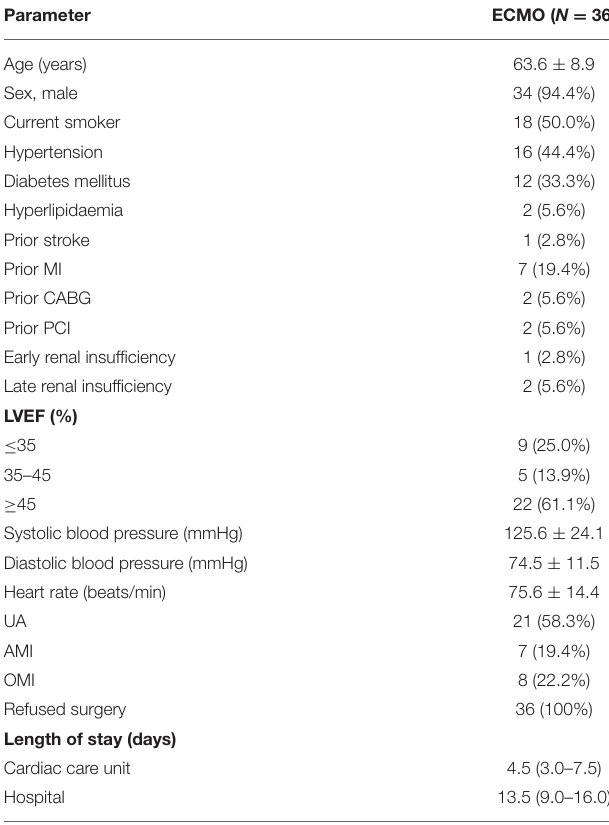
TABLE 1 | Baseline characteristics of patients included in the